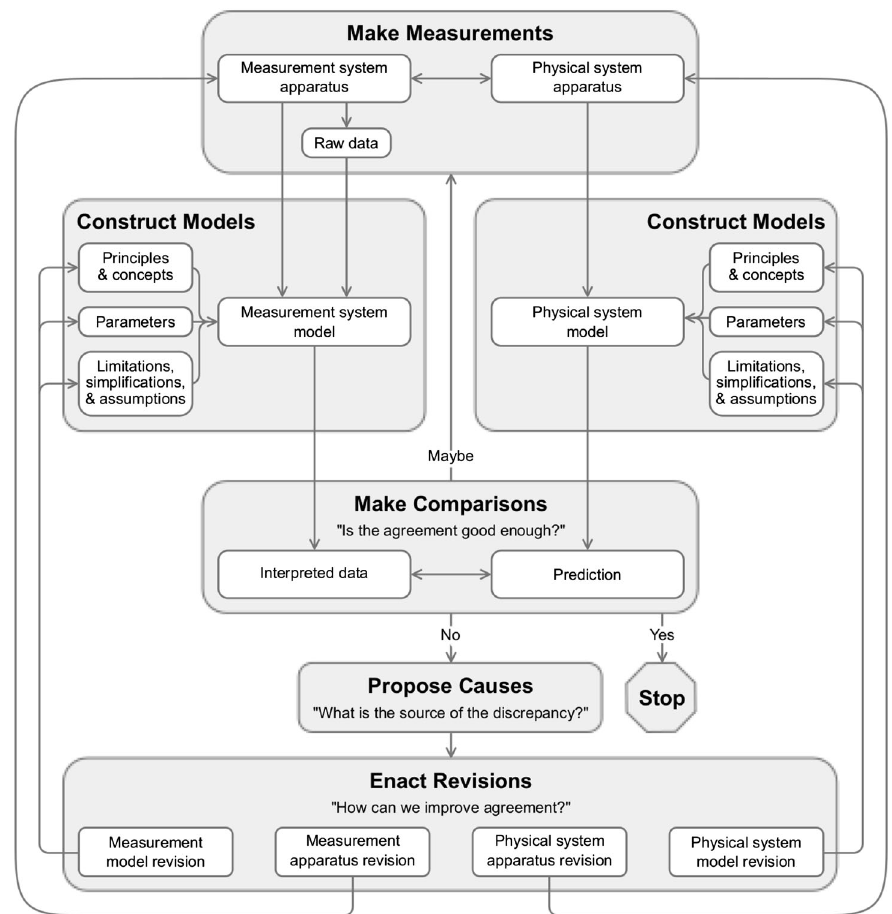
FIG. 1. Modeling Framework for Experimental Physics: Originally conceptualized by Zwickl et al. [12], this schematic of the Modeling Framework from Dounas-Frazer [9] shows how five interconnected tasks — construct models, make measurements, make comparisons, propose causes, and enact revisions — describe the ways scientists bring data and predictions from models into agreement. In the Modeling Framework, we distinguish between physical models or apparatus (e.g., models of the op-amp) and measurement models or apparatus (e.g., models of digital